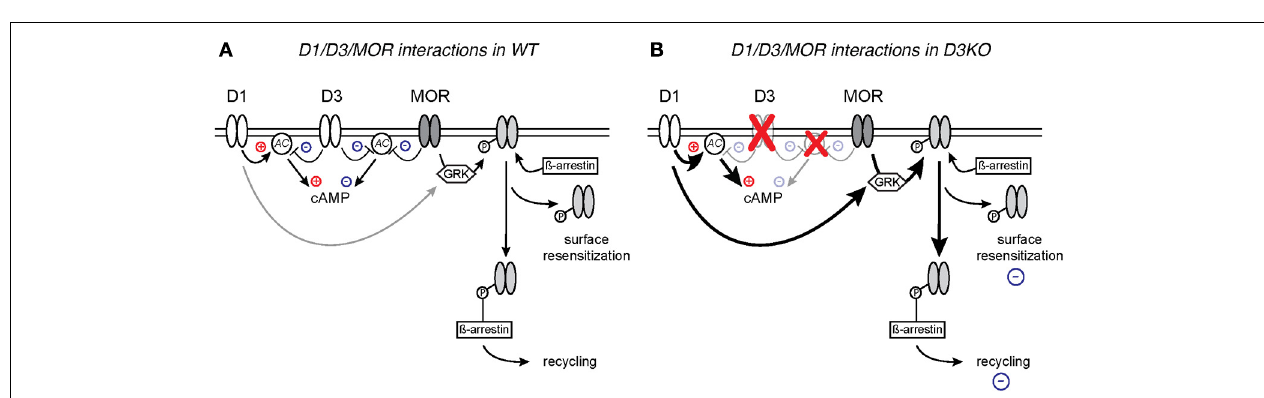
band that is present only in D3KO, and a weaker signal at the predicted band size of 49kDa that is differently expressed in WT and D3KO (arrows) and that was used for the subsequent analysis. (B) The quantification of the 49kDa expression labeling, normalized to ß-actin expression, revealed a significant increase in D1 receptor protein expression levels in D3KO ( ∗ p < 0 . 001).